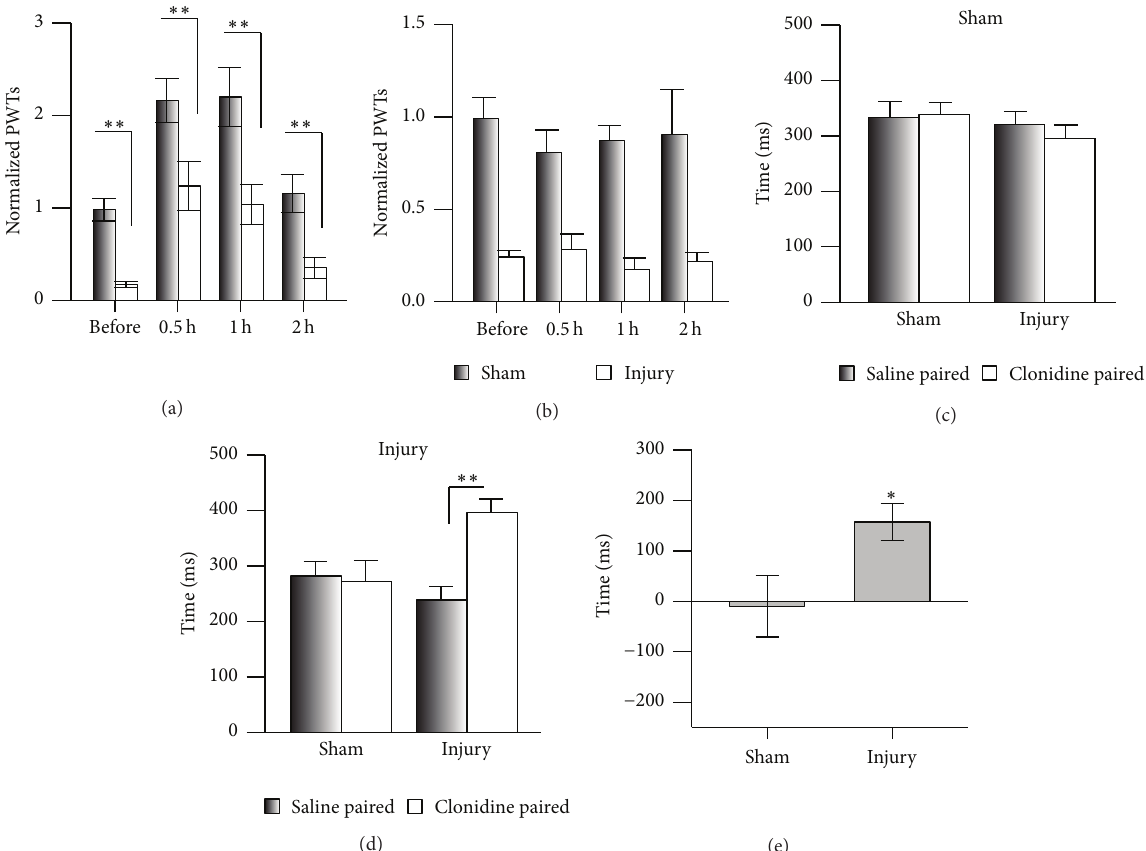
Figure 5: Infusion of clonidine into the anterior cingulate cortex alleviated spontaneous neuropathic pain. (a) Infusion of clonidine into the ACC increased the PWTs in the sham and nerve-injury groups (two-way RM ANOVA, sham versus injury: 𝐹 1;63 = 21.12 , 𝑃 < 0.01 ; treatments: 𝐹 3;63 = 23.13 , 𝑃 < 0.01 , 𝑛 = 7 for sham, 𝑛 = 9 for injury, ∗∗ 𝑃 < 0.01 under Tukey’s test). (b) Infusion of saline into the ACC had no effect on the PWTs (two-way RM ANOVA, sham versus injury: 𝐹 1;39 = 44.54 , 𝑃 < 0.01 ; treatments: 𝐹 3;39 = 0.29 , 𝑃 > 0.01 , 𝑛 = 5 per group). (c) Time spent in the chambers during the preconditioning period in the CPP test (two-way RM ANOVA, sham versus injury: 𝐹 1;31 = 3.54 , = 0.10 , 𝑃 > 0.05 , 𝑛 = 8 per group). (d) Infusion of clonidine into the ACC induced a preference for the 𝑃 > 0.05 ; saline versus drug: 𝐹 1;31 drug-paired chamber in the CPP test (two-way RM ANOVA, sham versus injury: 𝐹 1;31 = 4.13 , 𝑃 = 0.06 ; saline versus drug: 𝐹 1;31 = 4.06 , 𝑃 > 0.05 , 𝑛 = 8 per group, ∗∗ 𝑃 < 0.01 under Tukey’s test). (e) Hup A changed the preference time in the CPP test ( t -test, 𝑛 = 8 per group ∗ 𝑃 < 0.05